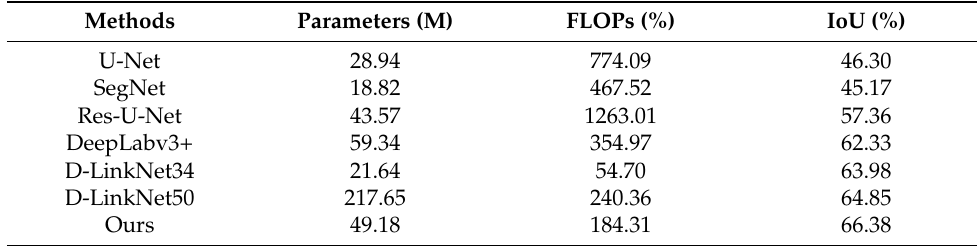
Table 6. The accuracy and efficiency of the related researches.